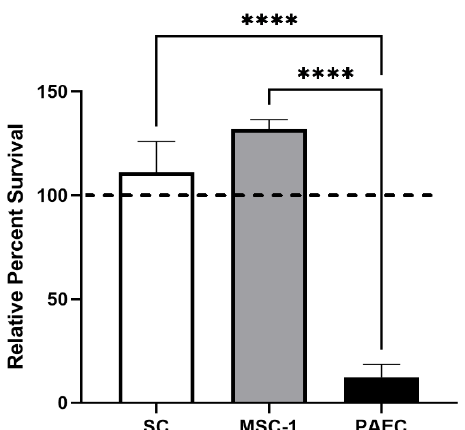
Figure 2. Mouse SCs survive after exposure to human serum in vitro. SCs (white bar), MSC-1 cells (gray bar), and control cells (PAECs, black bar) were exposed to human AB serum containing antibodies and active complement. Cell survival was assessed by MTT cell viability assay. Cell viability for cells cultured in medium only were set to 100% (dashed line) and the relative percentage viability was calculated for each cell type. Viability is presented as the mean ± SEM for at least three different experiments. The significance was determined by ANOVA and Fisher’s PLSD. **** indicates p < 0.0001.